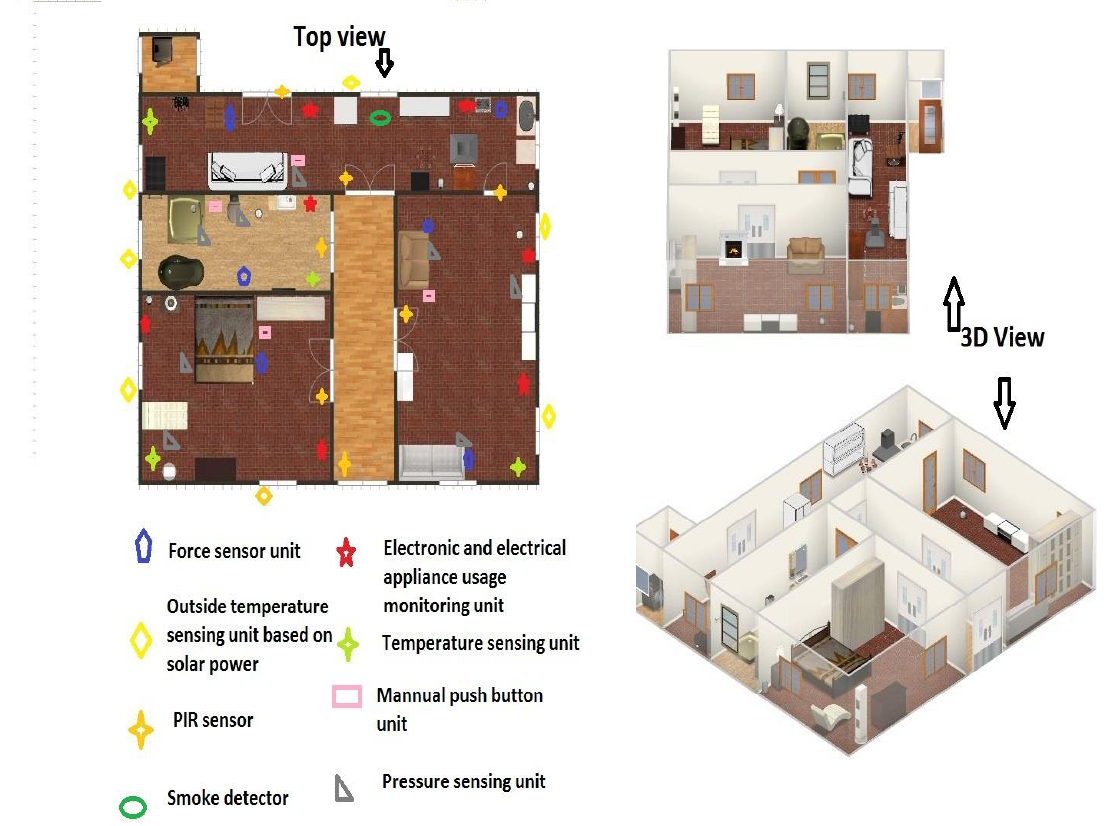
Figure 3. The layout of heterogeneous sensing units’ deployment in the AAL .